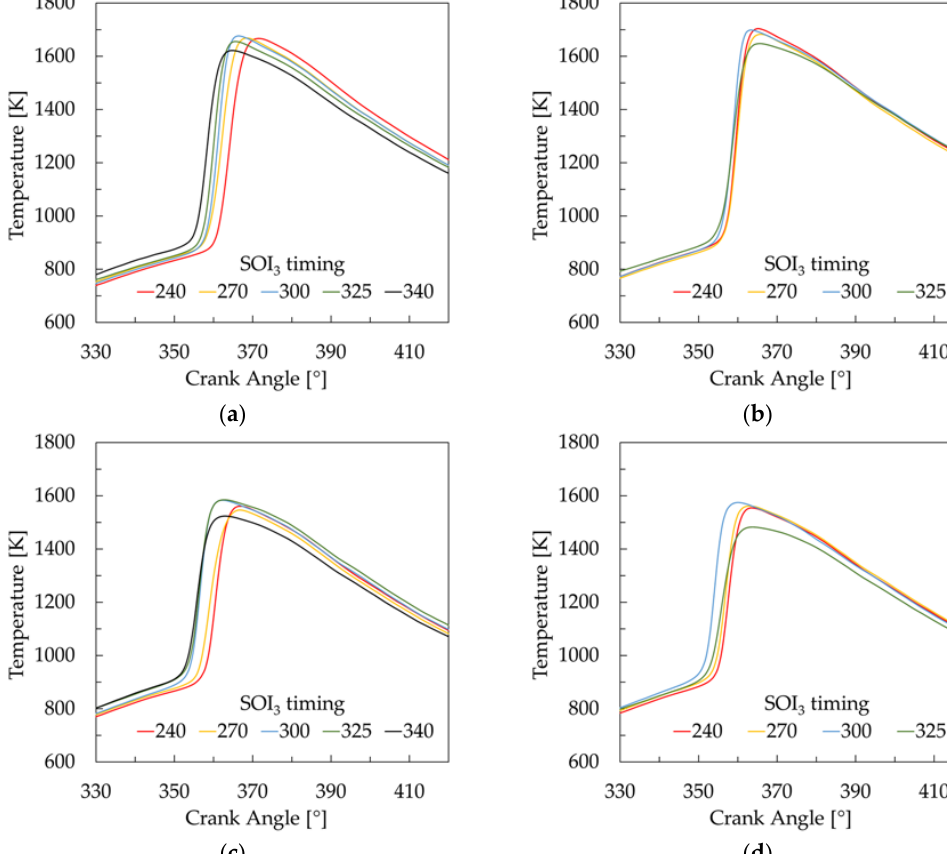
Figure 4. Calculated in ‐ cylinder temperature: ( a ) λ = 1.3, m F3 = 2.4 mg; ( b ) λ = 1.3, m F3 = 5.2 mg; ( c ) λ = 1.6, m F3 = 2.4 mg; ( d ) λ = 1.6, m F3 = 5.2 mg.